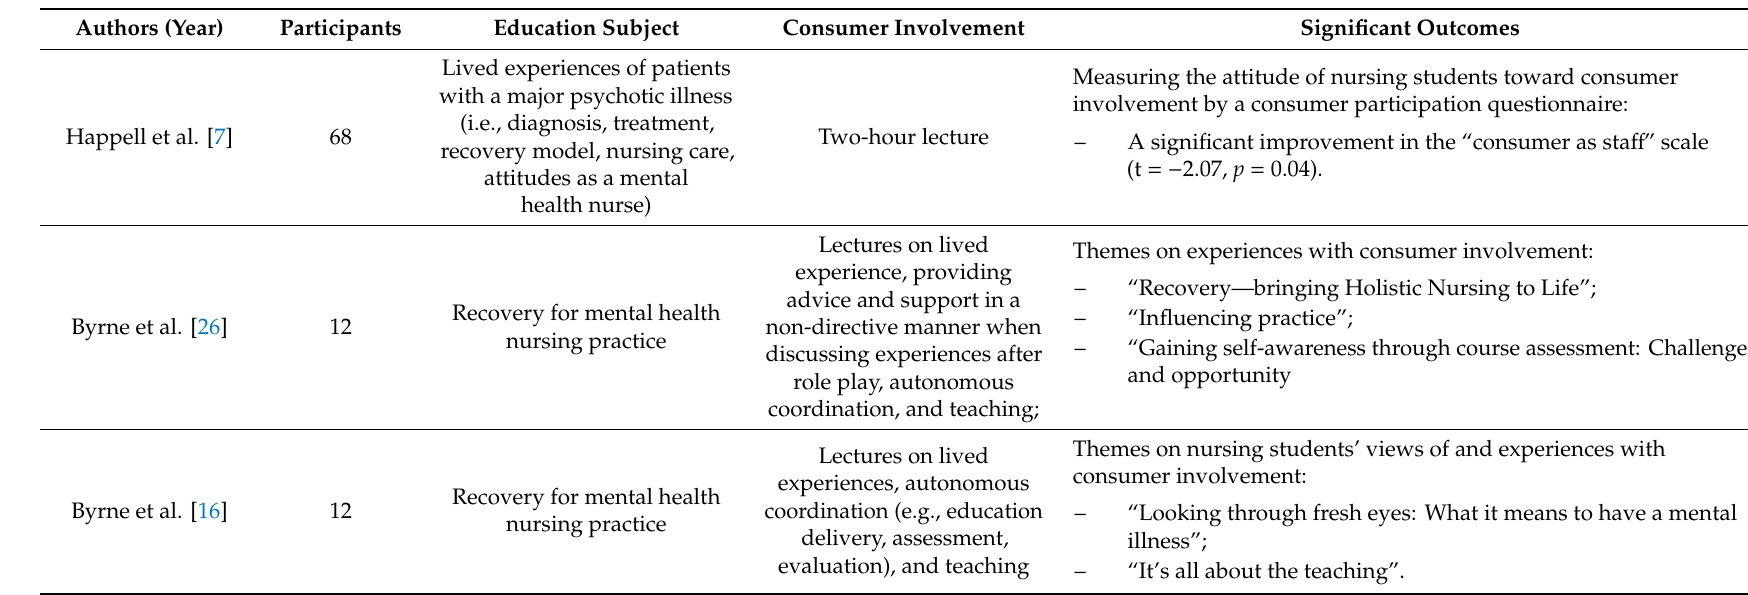
Table 2. Summary of consumer / patient involvement in educational programs regarding psychiatric and mental health